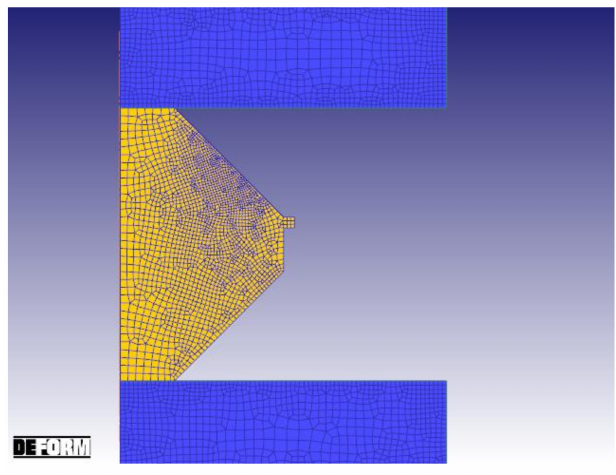
Figure 5. Double Cone simulation